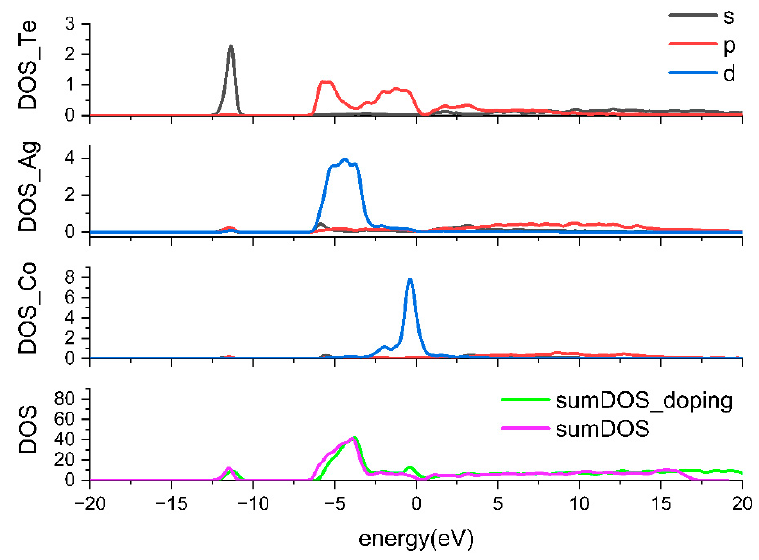
Figure 2. DOS function of Ag 2 Te. From top to bottom are the DOS contributions from the Te, Ag and Co atomic orbitals, with the total sum DOS at the bottom.